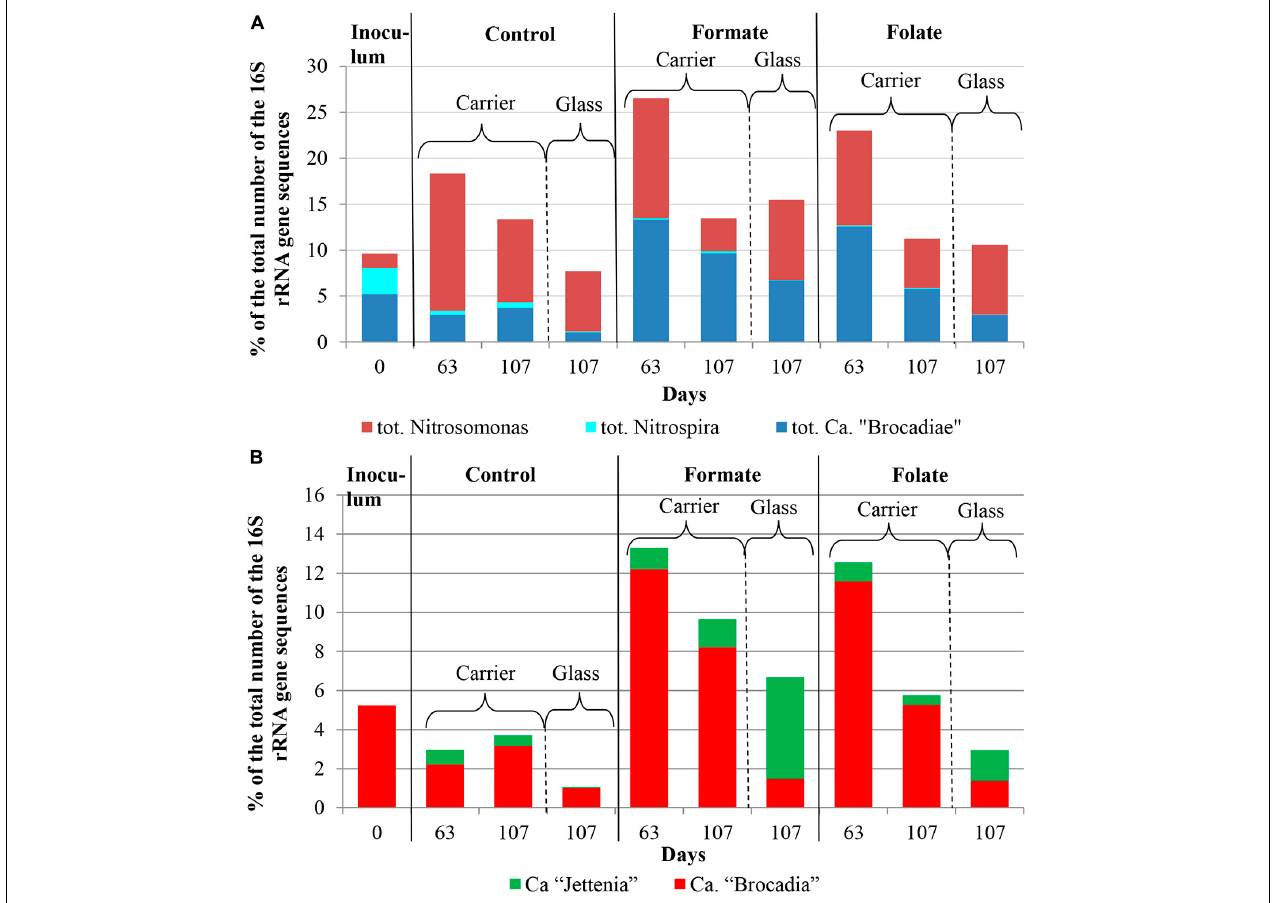
FIGURE 4 | The overall abundance of stage I (genus Nitrosomonas ) and stage II (genus Nitrospira ) nitrifiers and anammox bacteria (A) and the relative abundance of members of the genera Ca. “Jettenia” and Ca. “Brocadia” (B) in the inoculum and the biomass on the carrier and on the walls of the reactors (glass) before (the 63rd day) and after (the 107th day) the additives supplied and the ammonium load increased (the first run of the